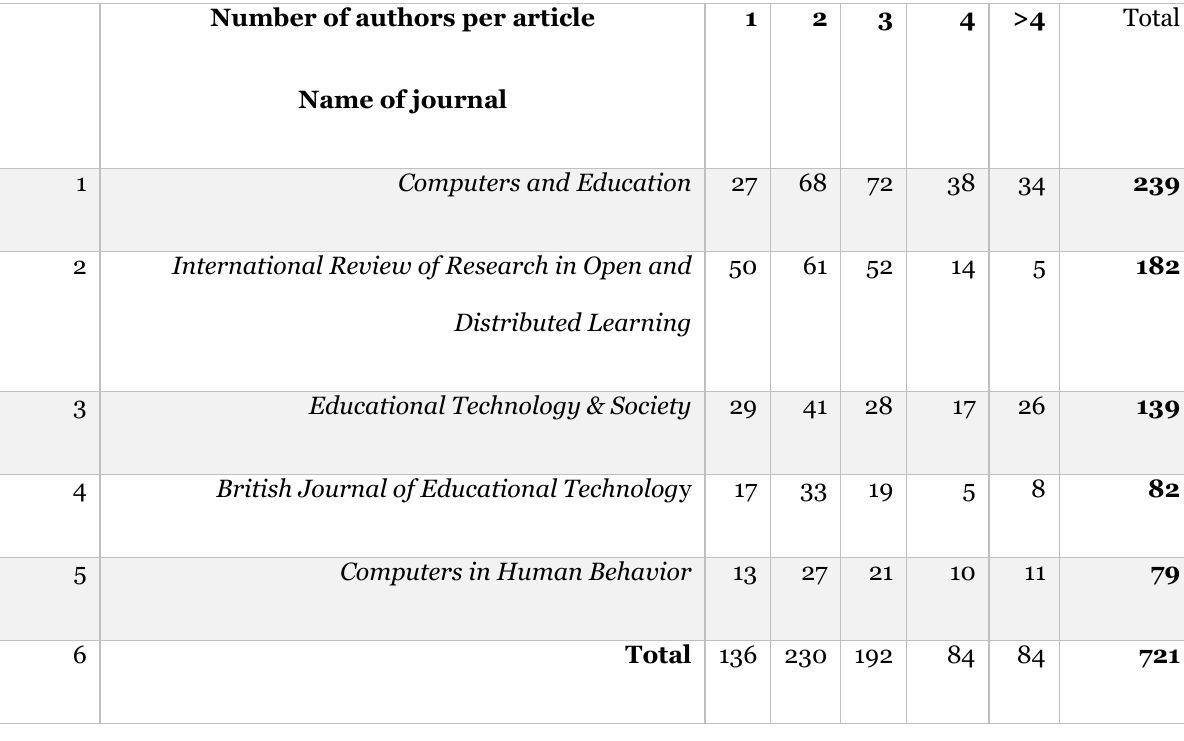
Collaboration Rate of Authors Publishing in Prolific E-learning